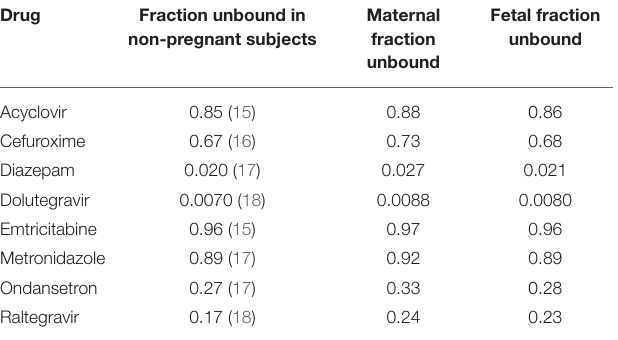
Drug Fraction unbound in non-pregnant subjects